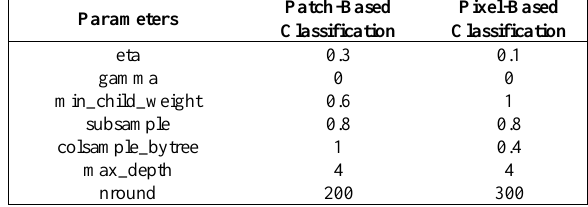
Table 2. Parameter values of XGBoost